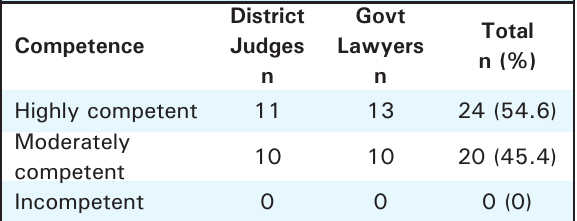
Table 5. Competence of forensic medical witness in the court of law